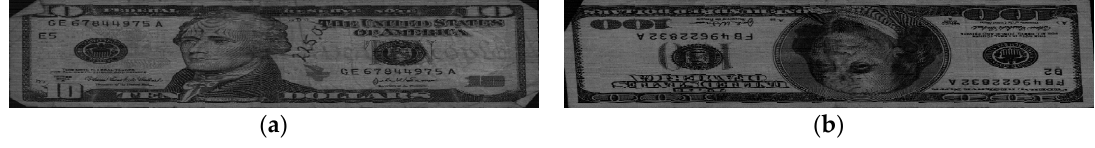
Figure 12. Examples of false recognition cases by our method in the USD dataset: ( a ) fit banknote misclassified to unfit; ( b ) unfit banknote misclassified to fit.